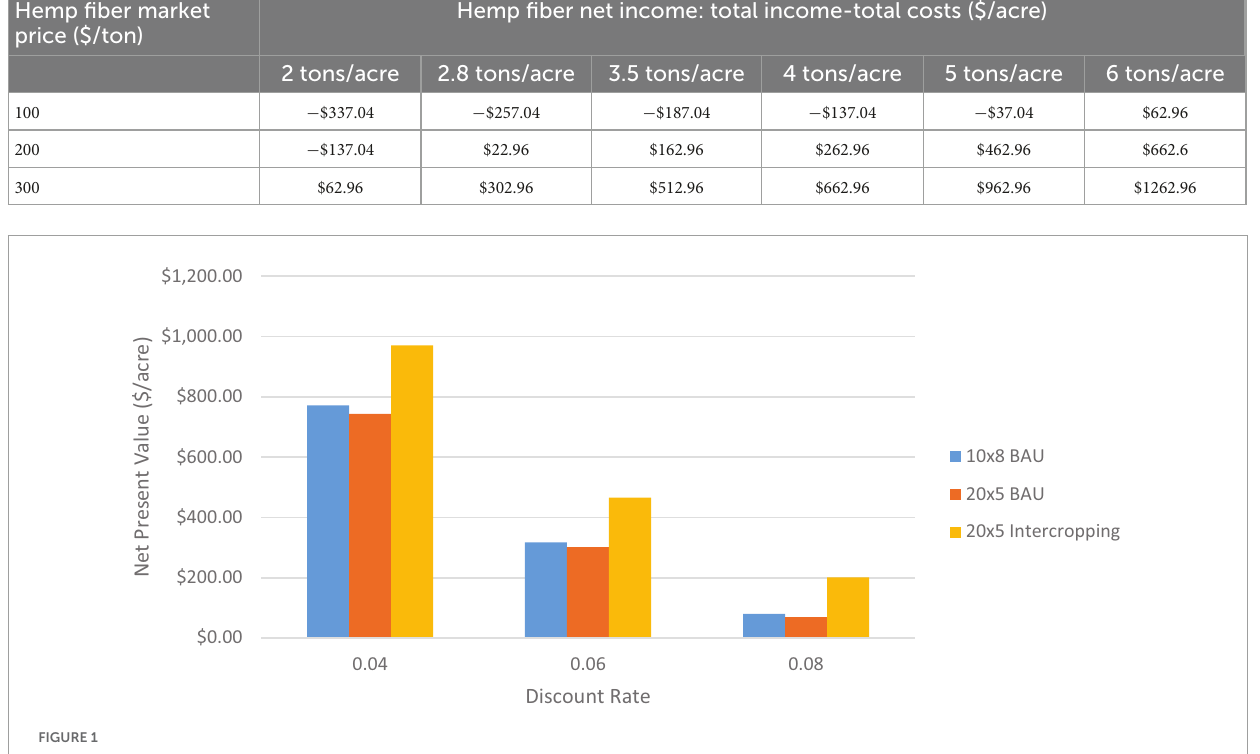
TABLE 5 Hemp fiber net income from intercropping under varying productivity and market price levels. Hemp fiber market price ($/ton)